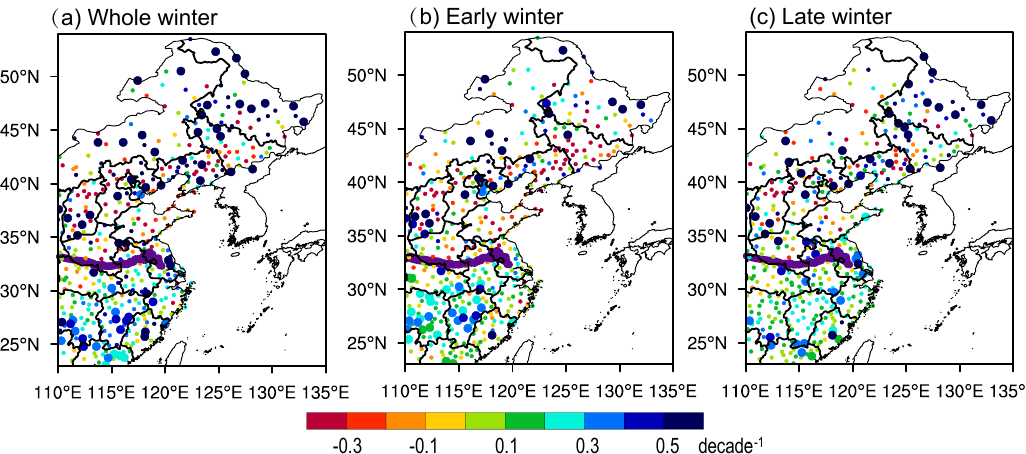
Figure 1. Trends of cold wave record numbers at each station in East China: The larger dots are the stations with a cold wave trend passing the 95% confidence level. The purple line is the Qinling Mountain–Huaihe River boundary, which forms the division between the northern and southern parts.